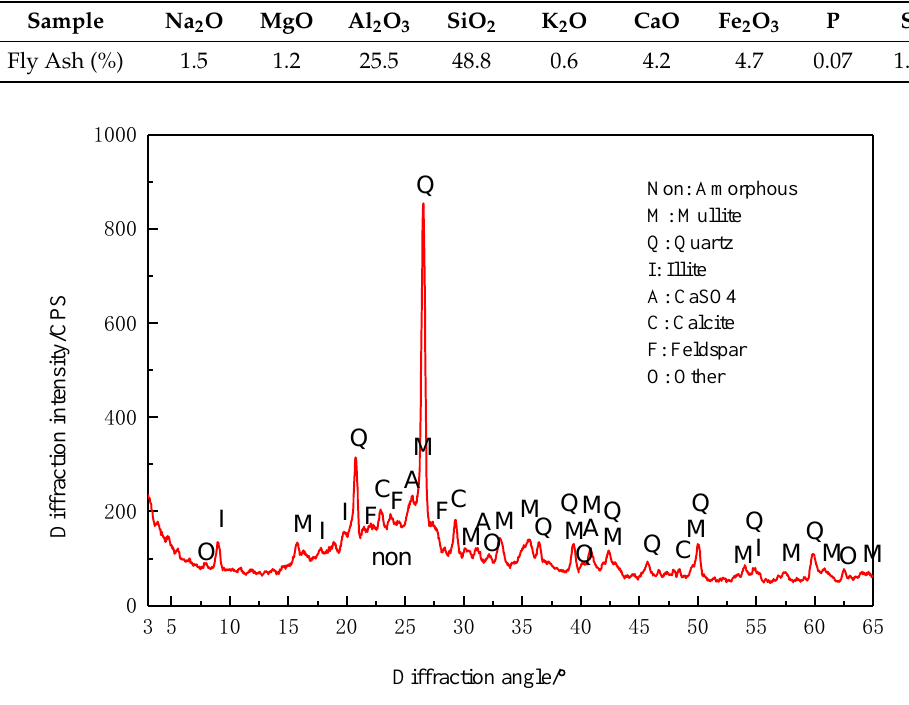
Figure 2. X-ray diffraction spectrum of fly ash. Table 2. Chemical composition of fly ash.